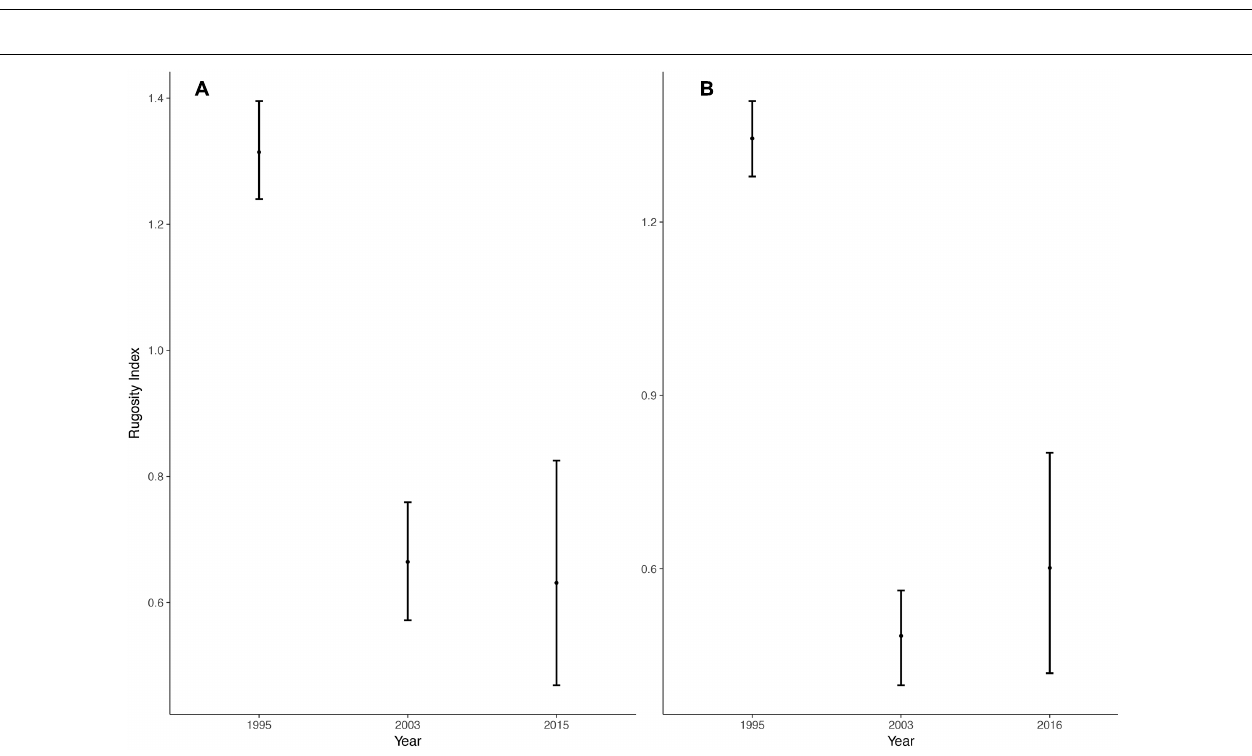
FIGURE 4 | Bottom complexity. Rugosity index means with 95% CI for three periods at (A) Roncador and (B) Serrana Banks.